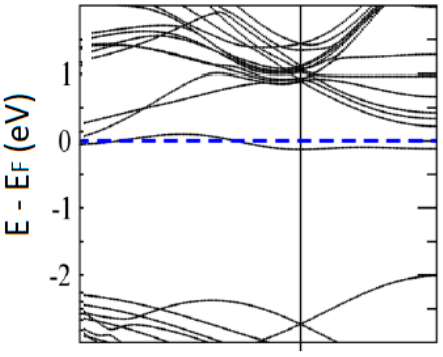
Figure 9. Dispersion curves for a buffer layer. Adapted with permission from Reference [31]. Copyright (2007) American Physical Society.